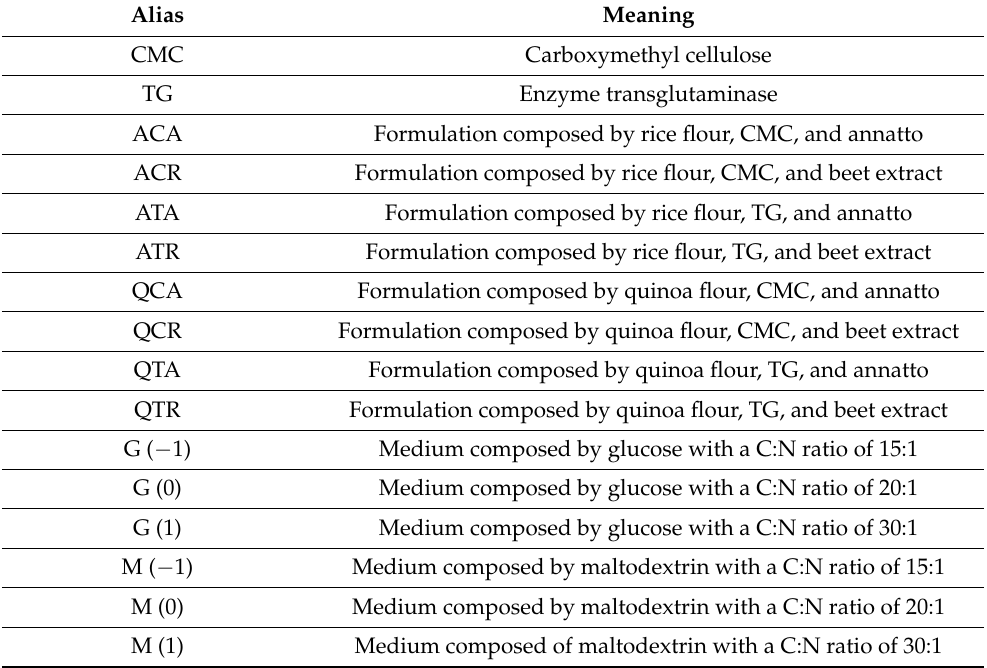
Table 2. Alias used in experimental